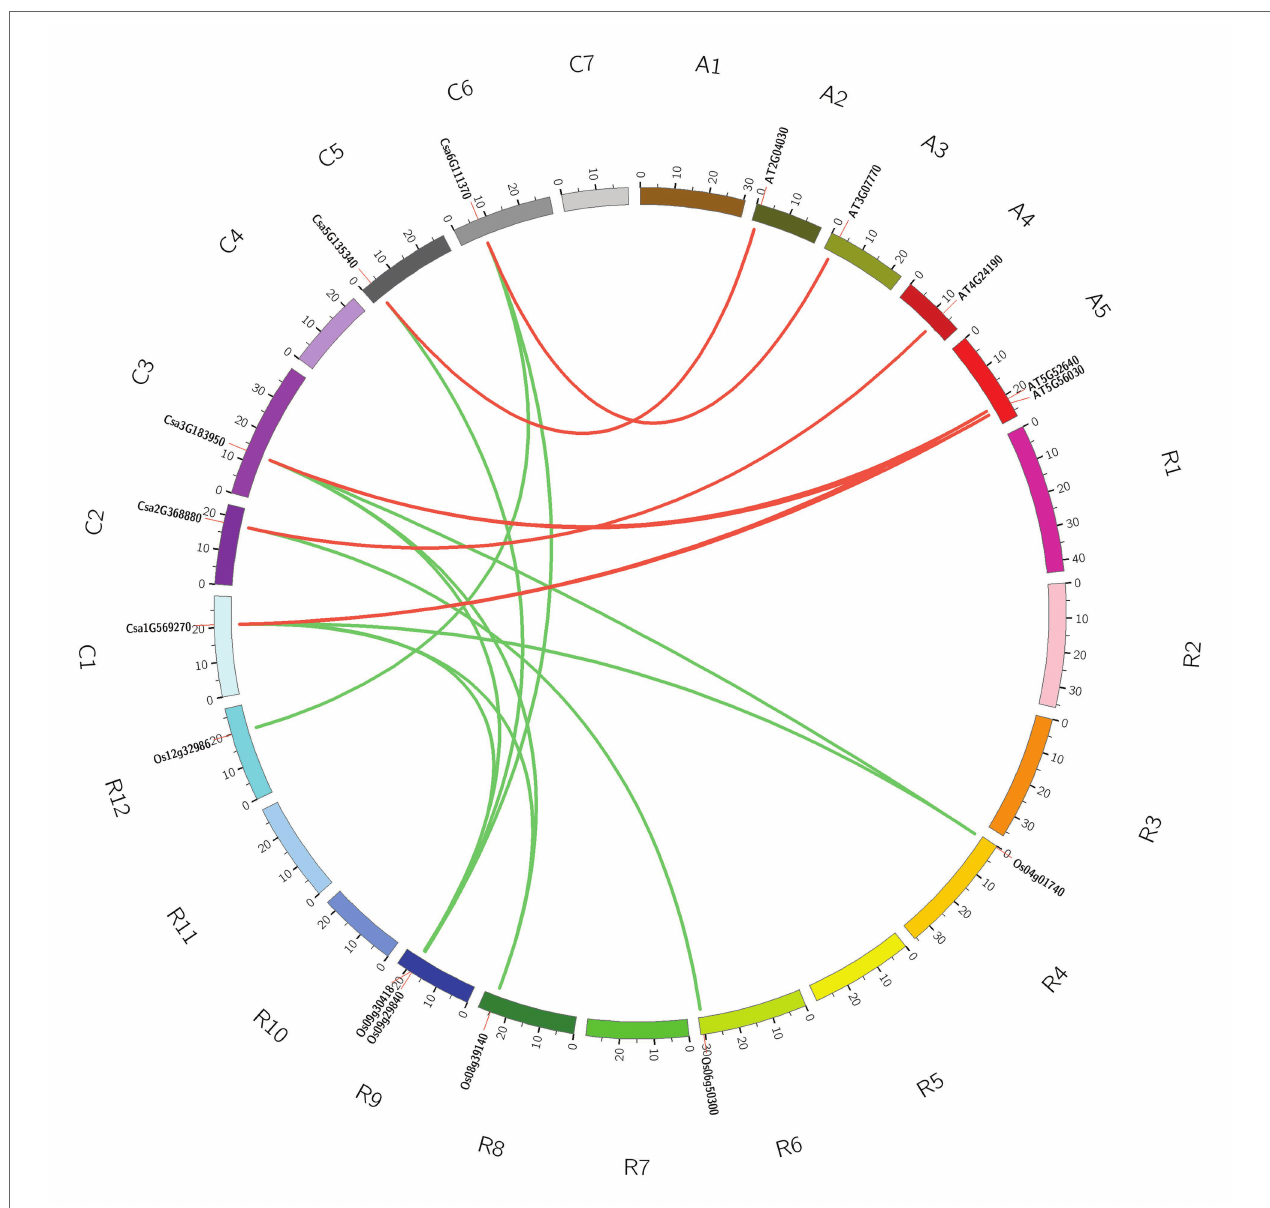
FIGURE 3 | Syntenic relationships of HSP90 gene family in cucumber, Arabidopsis , and